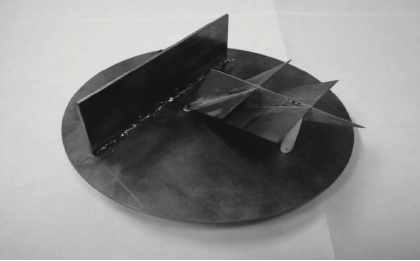
Figure 25: Proposed planar directional UWB antenna prototype.